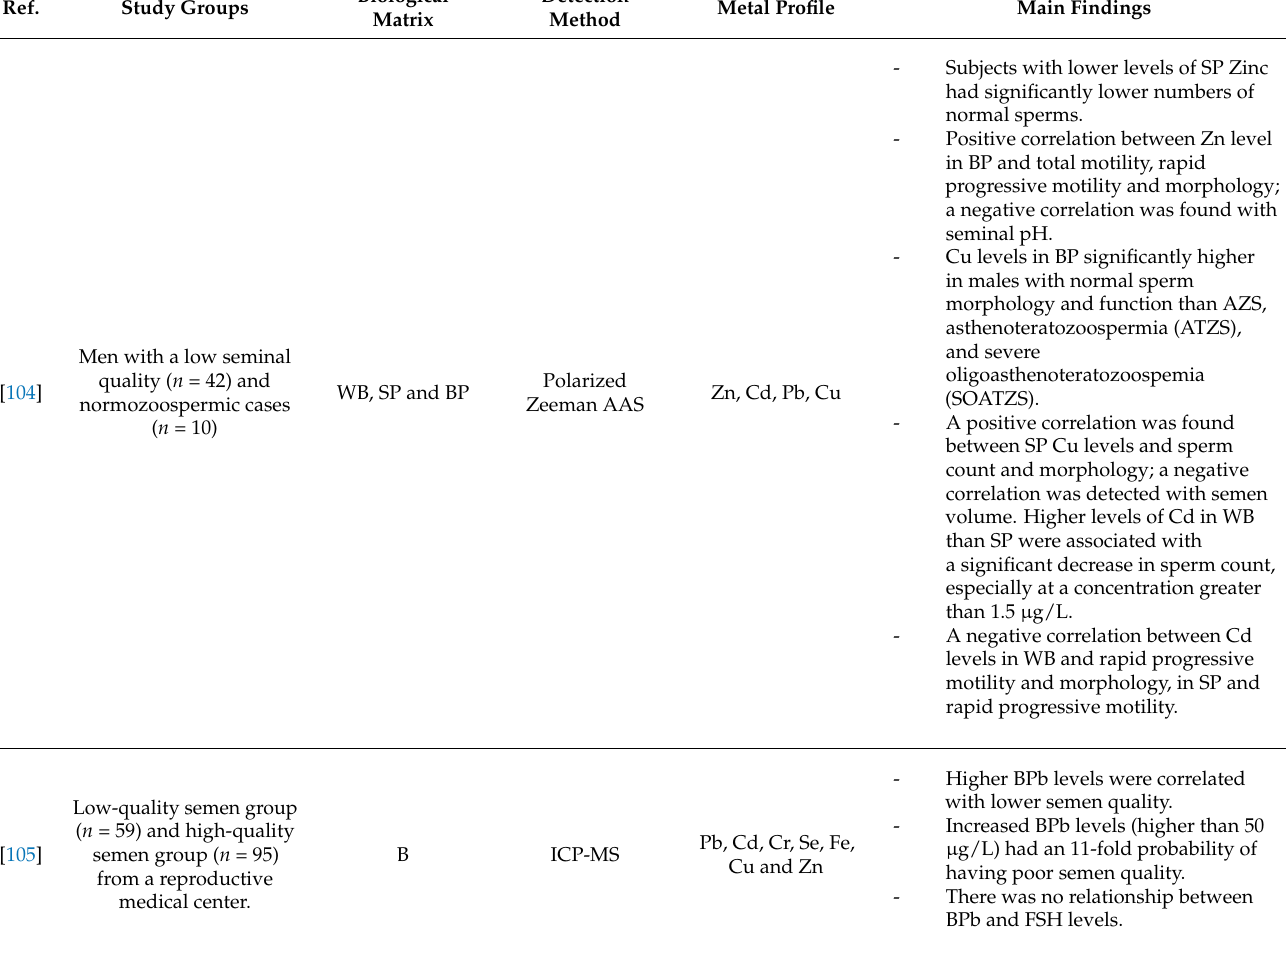
Table 5. Articles studying the relationship between heavy metals and reproductive parameters in study subjects from ART.